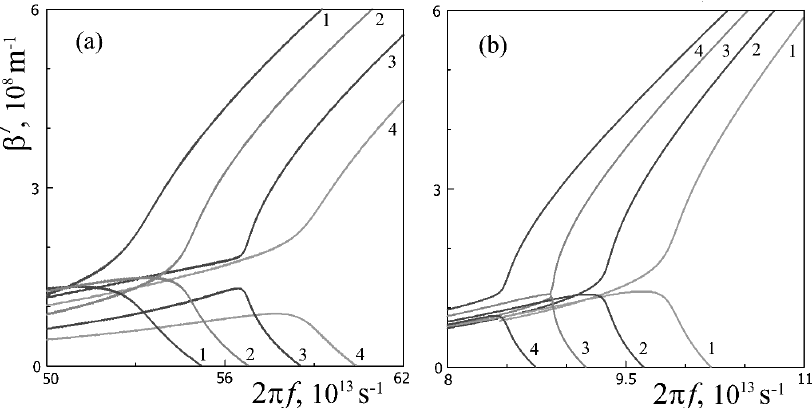
Figure 9. Frequency dependences of the plasmon propagation constant real part in a structure with ( a ) doped and ( b ) inverted graphene layers at µ = 0;0.02;0.25;0.03;0.35 eV (( a ), curves 1–4), ε 2 = 8, d = 30 nm; and at µ = 0.07 eV, ε 2 = 10, d = 30;34;38;40 nm (( b ), curves